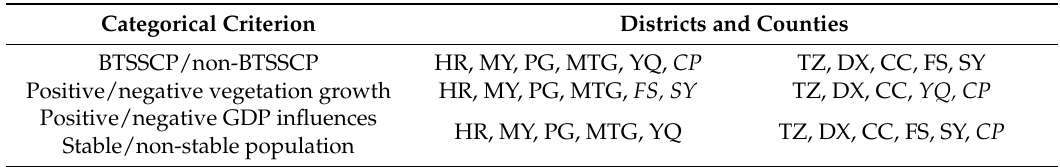
Table 6. Districts and counties under different categorical